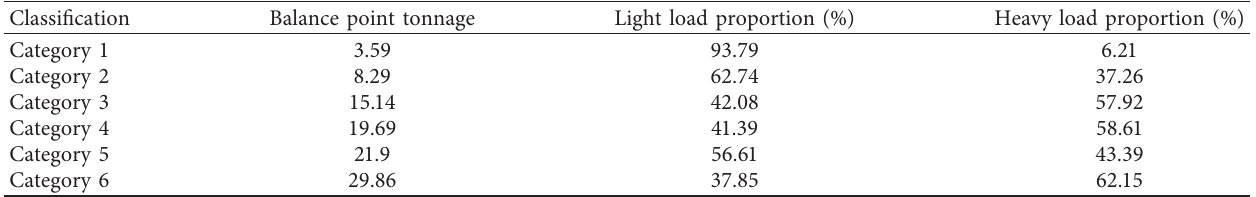
Table 5: Distribution of light and heavy loads in the ordinary highway network.